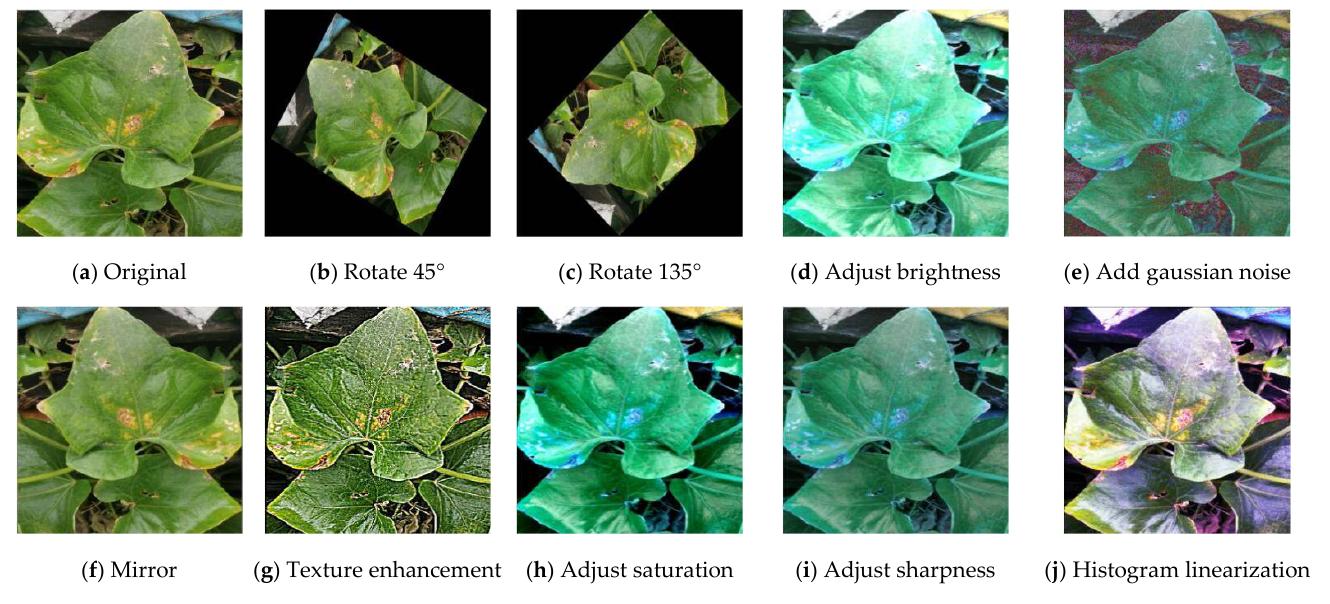
Figure 6. Traditional image data augmentation methods.